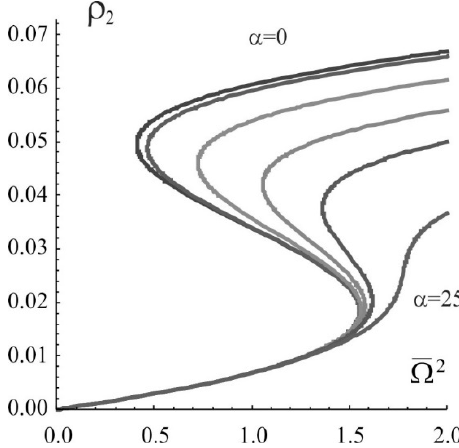
Figure 2. Bistable dependence of the population of the second (excited) level on the Rabi frequency for stationary homogeneous states.